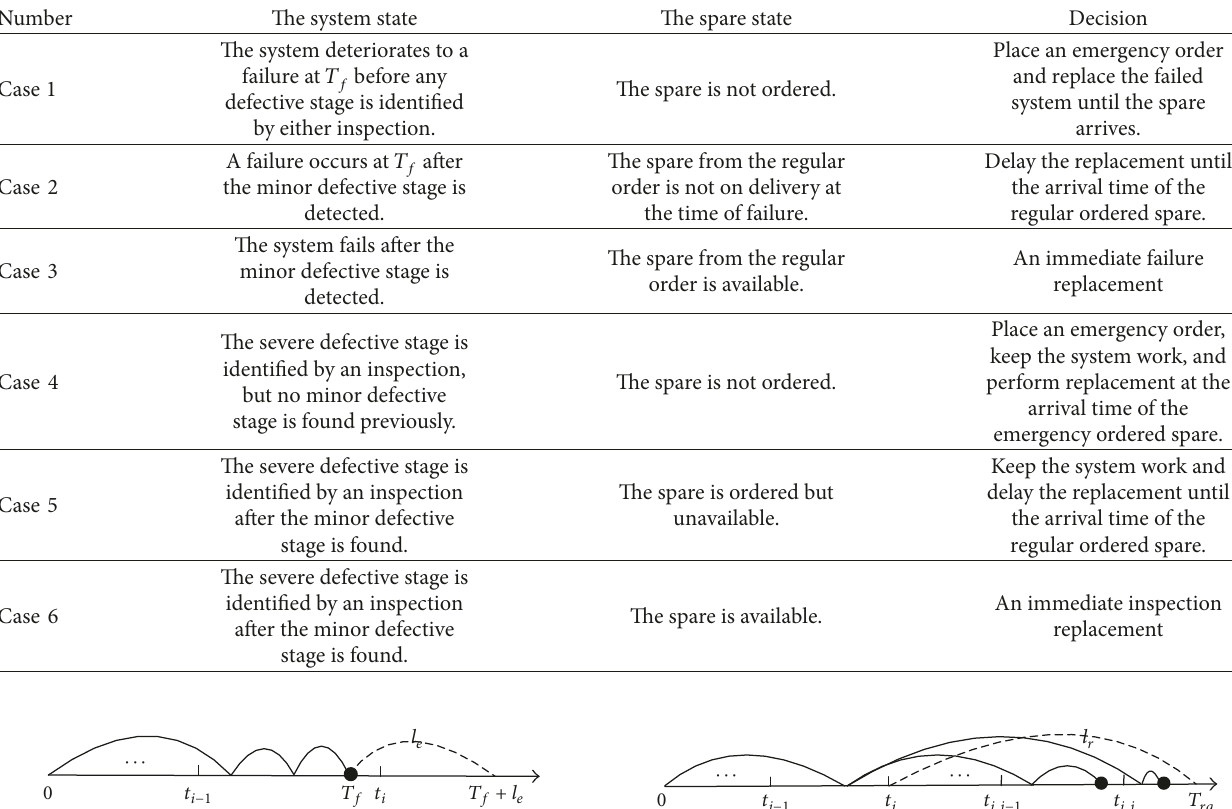
Table 1: Renewal scenarios of the joint inspection-based PM and spare ordering policy.